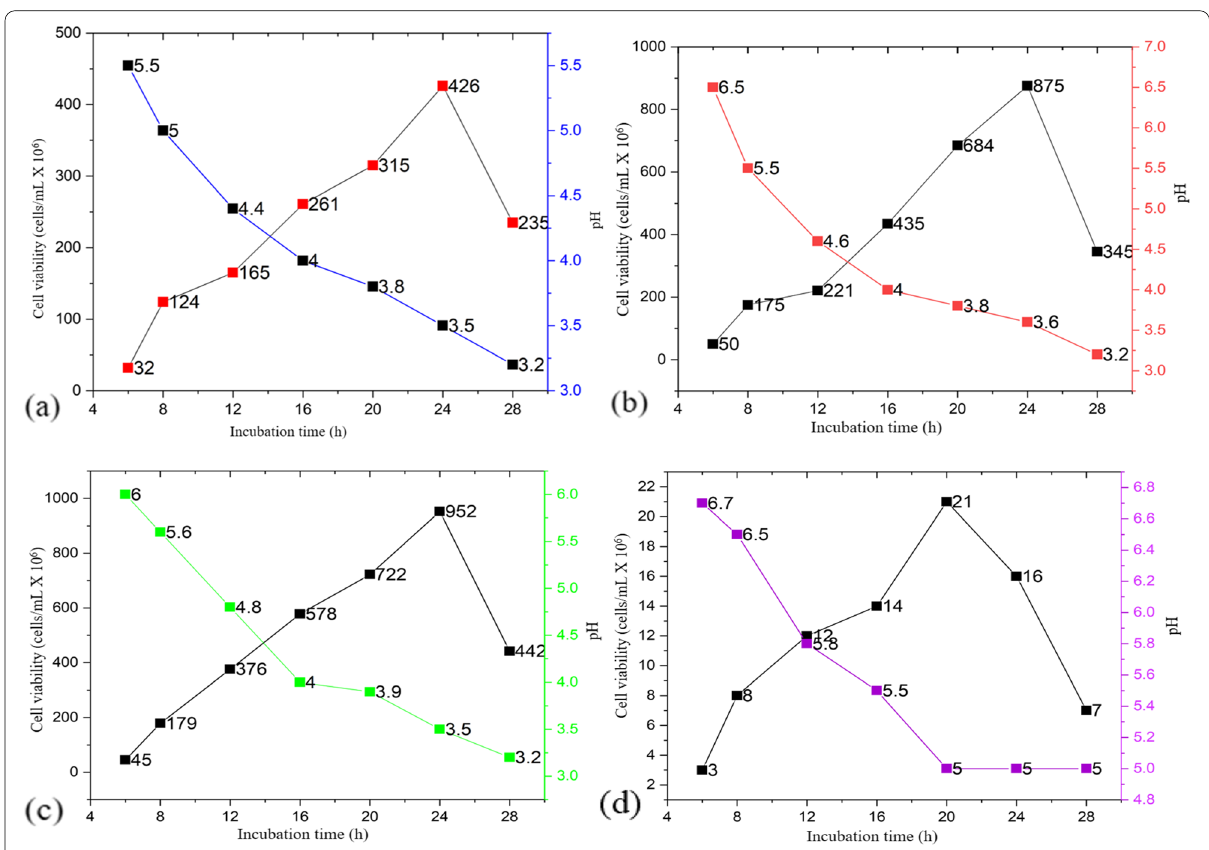
Fig. 1 The dynamics of yeast cell propagation as a function of pH and incubation period at 8 °Bx ( a ), 10 °Bx ( b ), 12 °Bx ( c ), and 14 °Bx ( d ). A